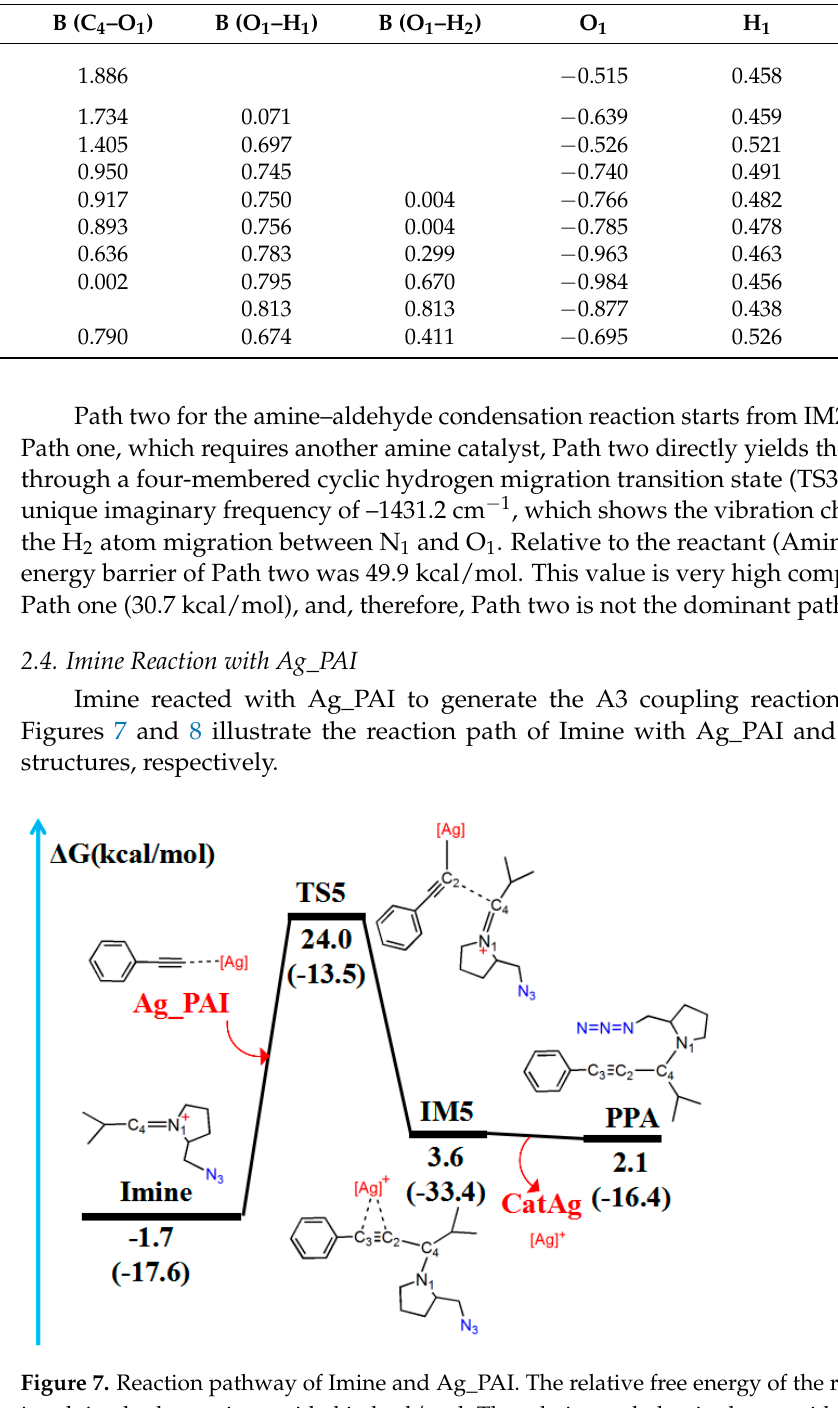
Figure 8. ( A ) Optimized geometries in the reaction pathway of Imine and Ag_PAI; the critical bond length is in Å . Hydrogen atom has been omitted for clarity. ( B ) Frontier orbitals of TS5. The reaction first forms a carbon–carbon (C 2 –C 4 ) bonding transition state (TS5). The Ag–C 2 (2.074 Å), C 2 –C 3 (1.234 Å), and C 4 –N 1 (1.334 Å) bonds in the TS5 configuration are longer than those (2.028, 1.222, and 1.283 Å, respectively) in the reactant (Ag_PAI + Imine). TS5 has a unique imaginary frequency of –134.8 cm − 1 , which shows the vibration charac- teristics of carbon(C 2 )–carbon(C 4 ) bonding. The frontier molecular orbitals of TS5 showed their respective carbon–carbon bonding reaction characteristics (Figure 8B). The C 2 p x or- bital appropriately combined with the C 4 p y orbital of the LUMO. The formation of IM5